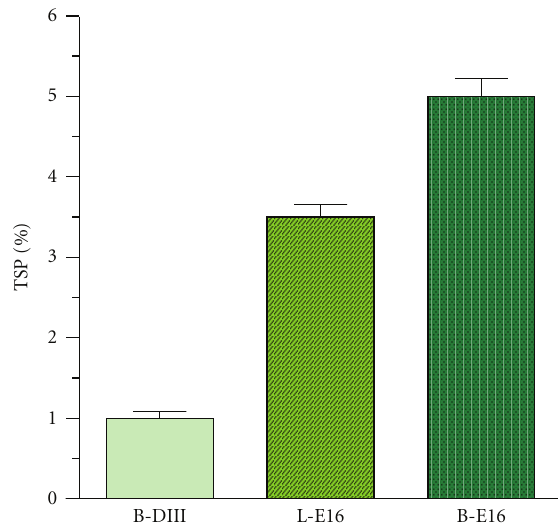
Figure 2: Accumulation of WNV DIII antigen and E16 mAbs in N. benthamiana and lettuce. Total proteins from plant leaves infiltrated with DIII or E16 expression vectors were extracted on 4dpi and analyzed by ELISA with E. coli -produced WNV DIII or mammalian cell-produced E16 as the reference standard. For DIII ELISA, a monoclonal mAb against WNV DIII [13] was the capture antibody, and a rabbit anti-WNV DIII antibody was the detection antibody. For E16, goat anti-human gamma- and kappa-chain antibodies were used as capture and detection reagents, respectively, to detect the assembled form of E16 mAb. Mean ± SD of samples from three independent infiltrations are presented. B-DIII: WNV DIII produced in N. benthamiana; L-E16: lettuce-produced E16; B-E16: N. benthamiana -derived E16 .